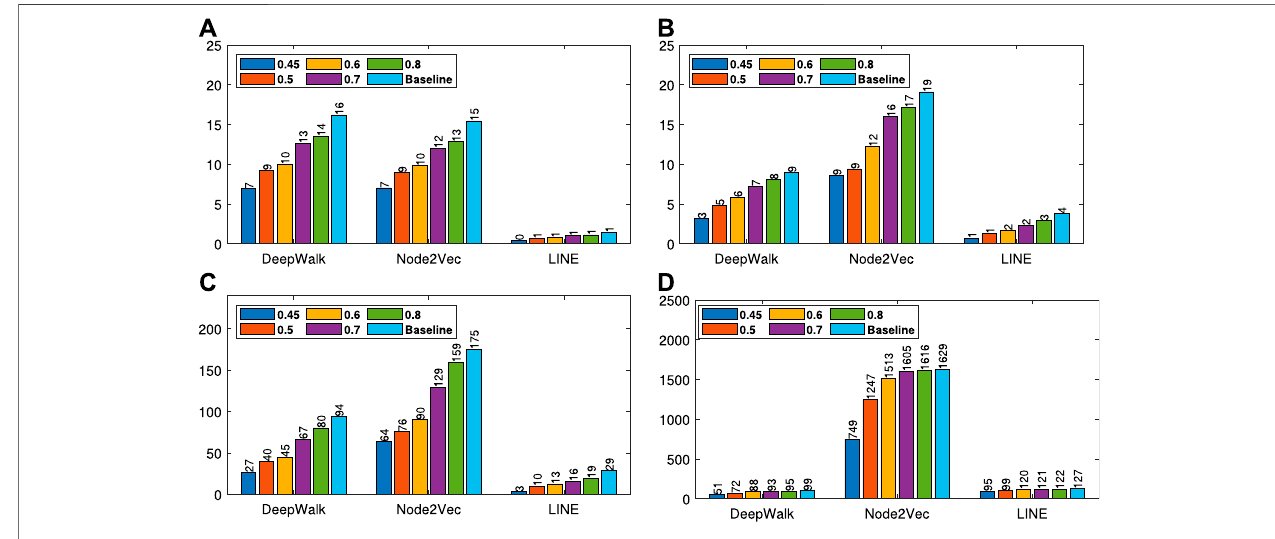
FIGURE 7 | Run time analyses for different similarity threshold values λ (Citeseer (A) , Wiki (B) , DBLP (C) and BlogCatalog (D) ).